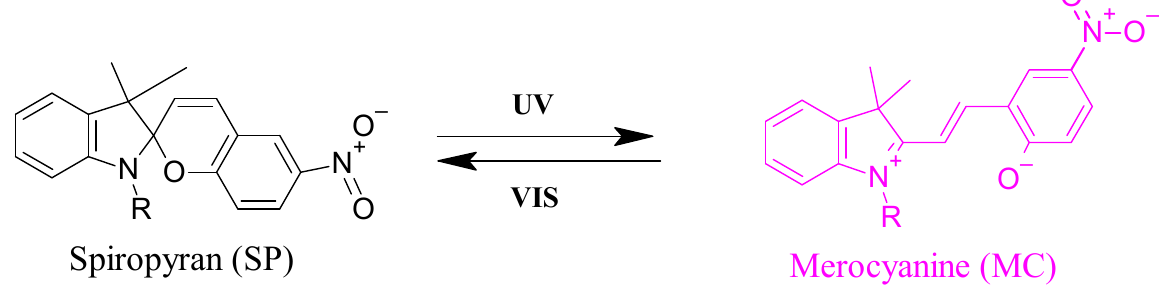
Figure 2. Photo switching between the spiropyran (SP) (left) and merocyanine (MC) form (right). SP is one of the chromophores that is not only a photo-switch but also responds to other stimuli such as temperature, solvent, metal ions, and pH [41]. In response to UV light ( λ = 365 nm), the closed nonpolar and colorless spiro form “SP” is transformed into the open, polar, colored and zwitterionic merocyanine form ”MC”. Irradiation with visible light ( λ = 550 nm) causes ring closure and return to the initial state. The UV-light induced reversible isomerization of SP between nonpolar and polar states can be used to tune the phase separation of thermo-responsive polymers since the (UV-induced) polarity change affects the interaction between the polymer and the solvent. By combination with different types of backbone polymers this enabled, e.g., controlled foaming or bubble formation using light irradiation of spiropyran sulfonate surfactants [42], rewritable optical storage in spiropyran-doped liquid crystal polymer film [43], or controlling the enzymatic activity on orthogonally functionalized glycidyl methacrylate with spiropyran [44]. SP-incorporating poly (oligo (ethylene glycol) acrylate)-based copolymers have been synthesized by mol%). The visible light irradiation of the copolymer dissolved in pH 8 TRIS buffer re- sulted in a decrease in its cloud point temperature by 30 K at 16 mol% SP content, as pre- viously detected by UV/Vis spectroscopy [45].